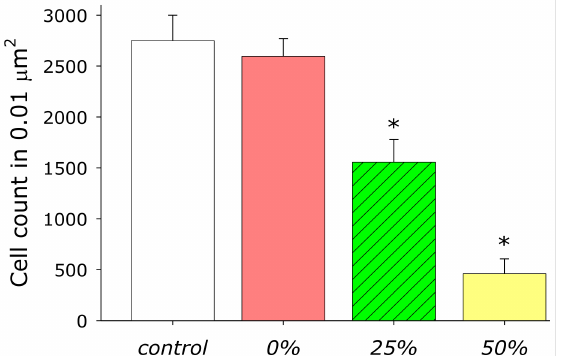
Figure 14. Influence of material AP-ZnO on E. coli growth and development. * indicates a significant difference at 5% level in comparison with the control ( p < 0.05). Data are presented as mean values and standard